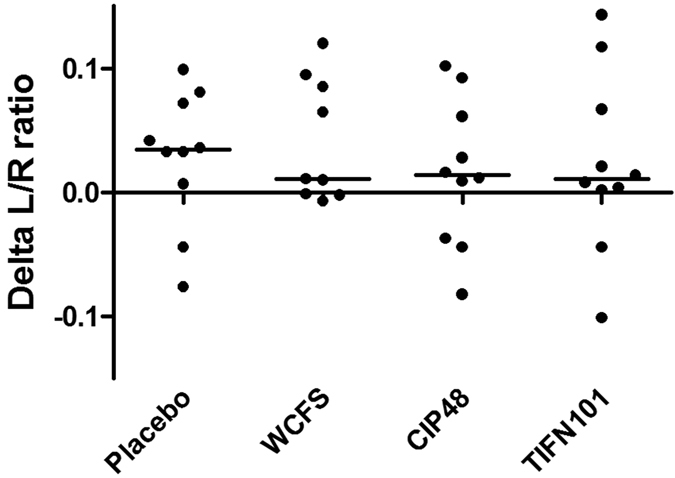
The effect of three L. plantarum strains and placebo on L/R ratio.Delta L/R ratio: L/R ratio after supplementation and stressor minus L/R ratio before supplementation and stressor. Scatterplot with median line presented. No statistically significant difference found between test periods, tested with related samples Wilcoxon signed rank test.